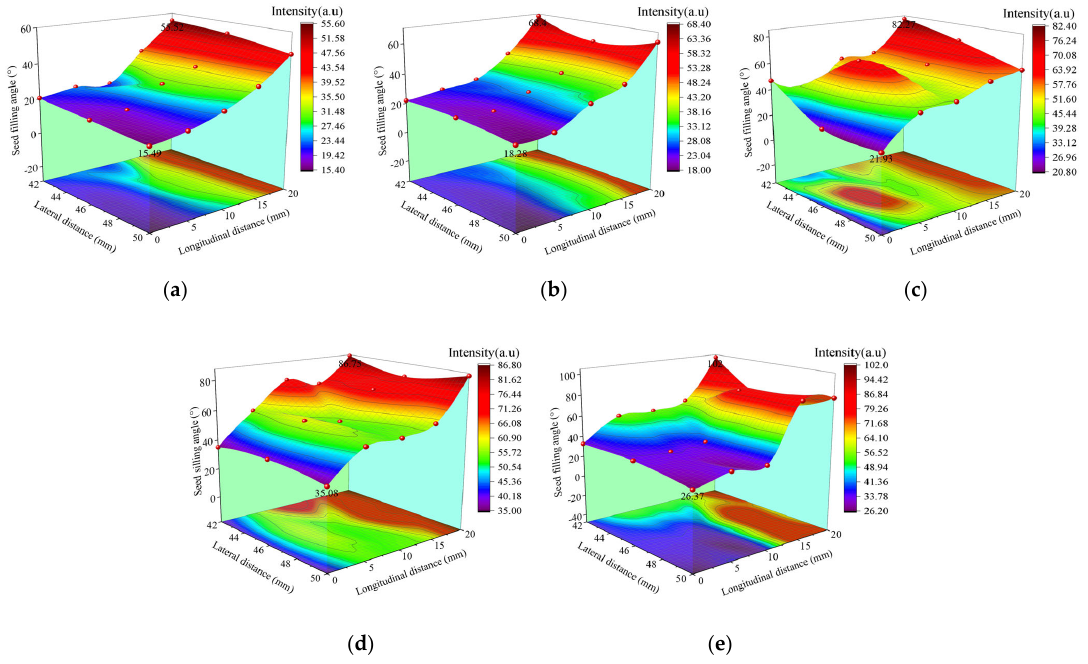
Figure 13. Effect of vibration on seed − filling angle under different frequencies: ( a ) 0 Hz, ( b ) 10 Hz, ( c ) 20 Hz, ( d ) 30 Hz, and ( e ) 40 Hz. Figure 14a shows the seed ‐ filling situation at a longitudinal distance of 20 mm, a lateral distance of 50 mm, and a vibration frequency of 30 Hz. Though the larger seed ‐ filling angle favored seed filling, the number of retained seeds after bounce increased significantly, resulting in an increased seed ‐ damage ratio and multiple ratios of seed filling. As shown in Figure 14b, the seed ‐ filling angle was large at a longitudinal distance of 10 mm, a lateral distance of 50 mm, and a vibration frequency of 30 Hz. There were only a few retained seeds after the bounce, indicating that seed ‐ filling performance was improved by optimizing the longitudinal distance. The phenomenon of seeds tilting to one side was observed at larger longitudinal and lateral distances and at higher frequencies of vibration (Figure 14a), which needed to be further investigated. ( a ) ( b ) Figure 14. Effect of longitudinal distance on the number of retained seeds at 30 Hz: ( a ) h = 20 mm, and ( b ) h = 10 mm. Note: The yellow line indicates the seeds in the seed ‐ filling area, and the green line indicates the retained seeds. The target seed rate was improved by adjusting various longitudinal distances under different vibration frequencies. The target seed rate was more than 91% with a longitudinal distance of 15–20 mm at 0 Hz, a longitudinal distance of 10–20 mm at 10 Hz, a longitudinal distance of 5 mm at 20 Hz, a longitudinal distance of 0–15 mm at 30 Hz, and a longitudinal distance of 5–10 mm at 40 Hz. 3.4. Discussion